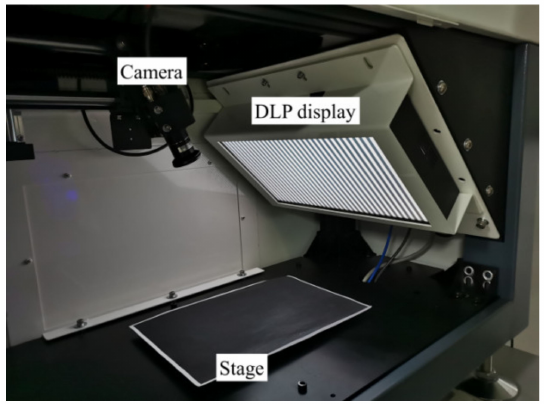
Figure 5. PD defect detection